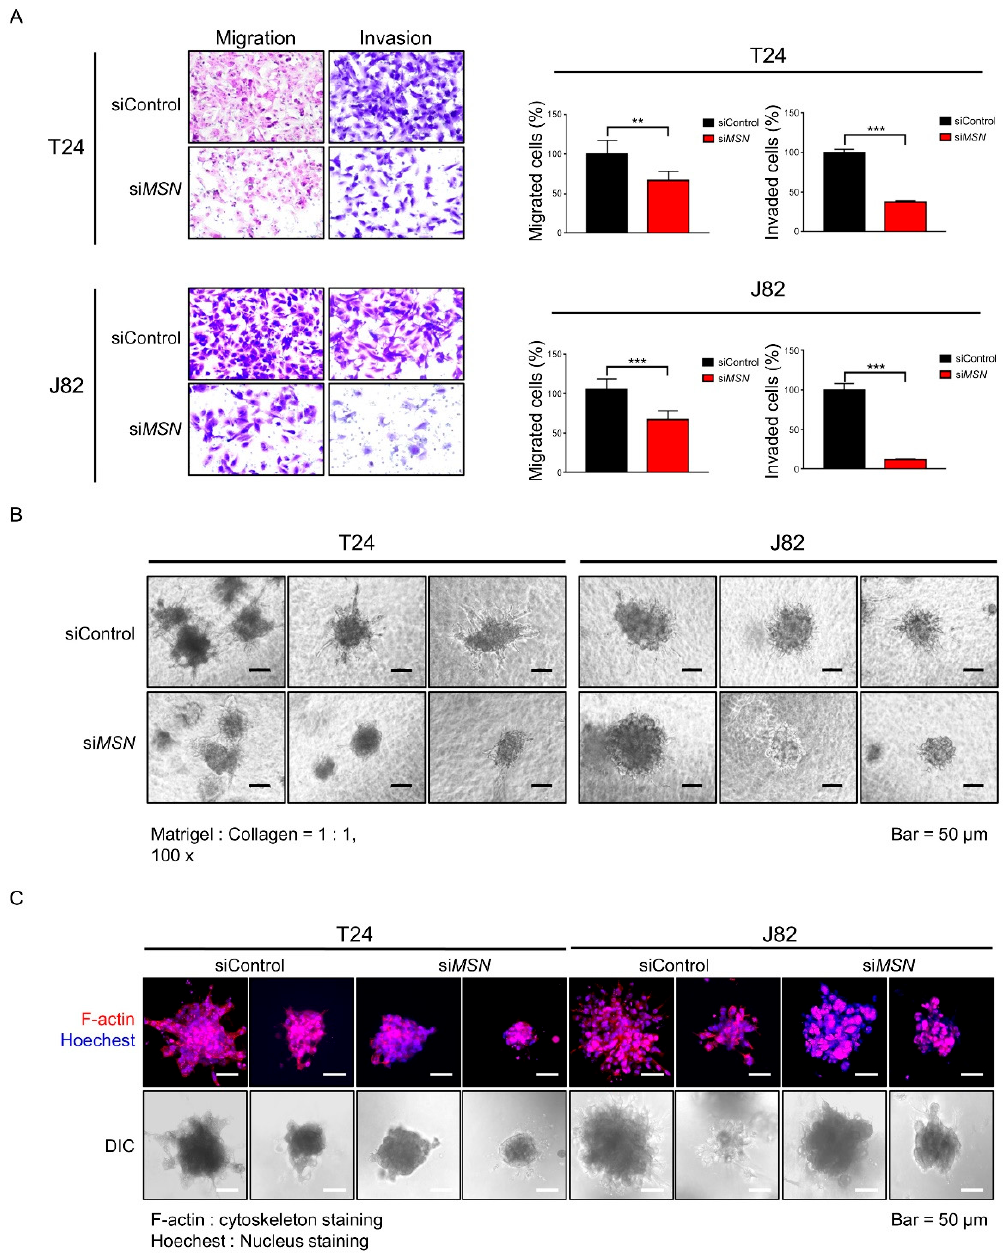
Figure 4. Functional validation of invasive role of MSN with small interfering RNAs (siRNAs) using two-dimensional (2D) and three-dimensional (3D) migration and invasion assays. ( A ) 2D migration and invasion assay (statistical significance, ** p -value < 0.01; *** p -value < 0.001). ( B ) Phase-contrast microscope image of 3D dissemination. ( C ) Confocal microscope image of 3D dissemination.